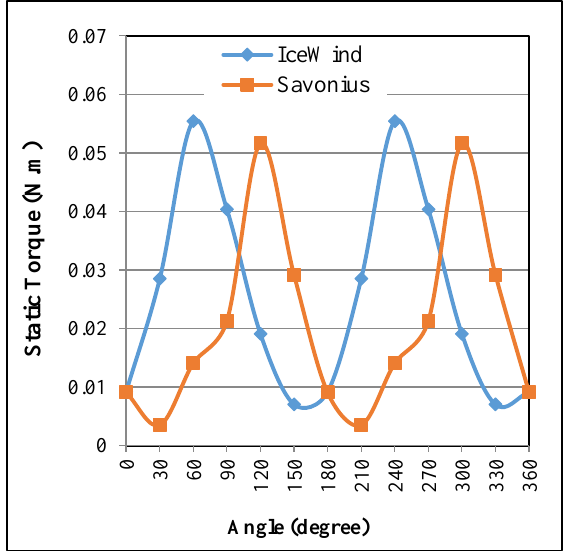
Figure 17. Relation between static torque and the rotation angle for the IceWind and Savonius turbines at an air velocity of 15.8 m/s.